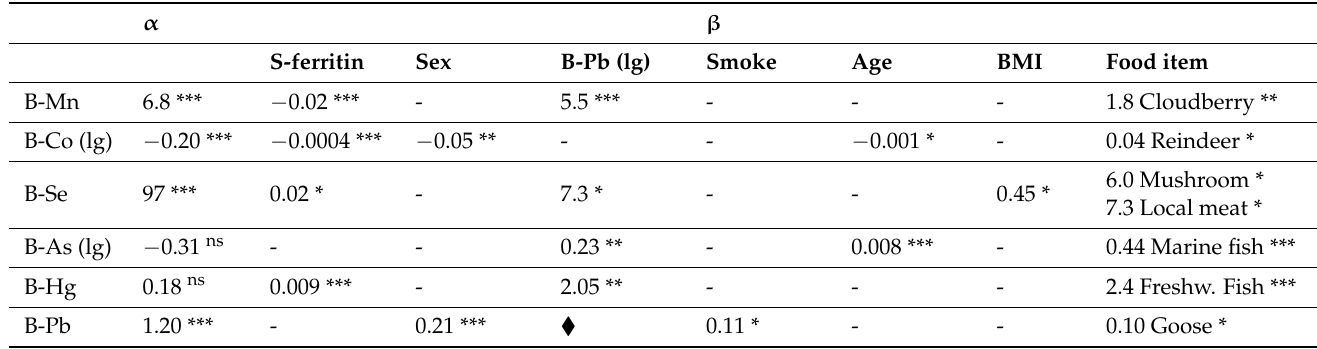
Table 3. Multiple linear regression analysis (backward procedure) including S-ferritin, gender, B-Pb (lg), current smoking, age, BMI, and various food items as independent